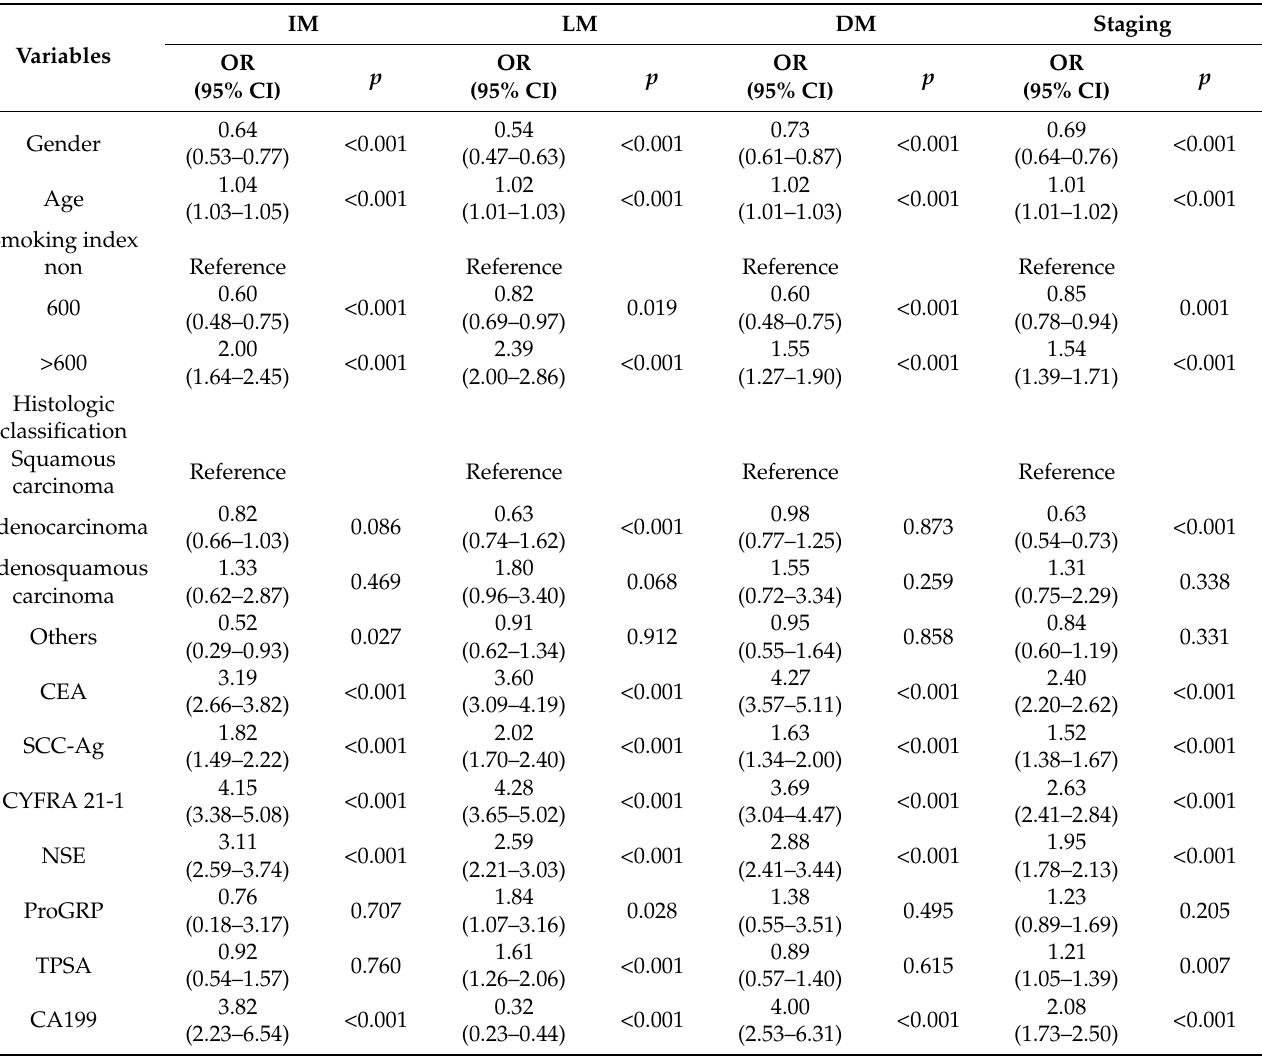
Table 5. Univariate analysis of influencing factors for tumor metastasis and clinical stage in patients with NSCLC.